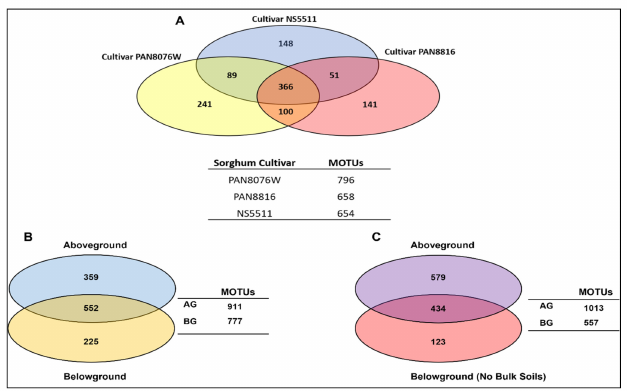
Figure 3. Venn diagram depicting shared and unique fungal Molecular Operational Taxonomic Units (MOTUs) in the three sorghum cultivars ( A ), combined cultivar MOTUs for all niches, above- and below-ground ( B ), and combined cultivar MOTUs above- and below-ground ( C ) (Bulk soils excluded). When comparing the number of MOTUs between cultivars (Figure 3A), PAN8076W had 796 MOTUs compared to PAN8816 (658) and NS5511 (654). A considerable number of MOTUs were shared between the cultivars (366). PAN8076W and PAN8816 shared the highest number of MOTUs (100), followed by PAN8076W and NS5511 (89), and NS5511 and PAN8816 (51). The relative abundances of some of the dominant MOTUs between cultivars were similar, while with others there were large differences (Table 3). For instance, Didymellaceae sp. 1 ( Phoma ) had double the RA in the seed of NS5511 (11.3%) and